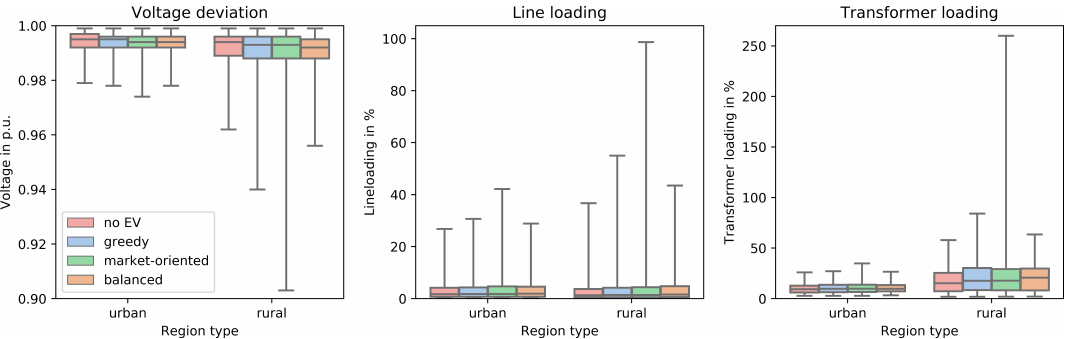
Figure 8. Load profile for each charging strategy in Berlin for 2 days in the private